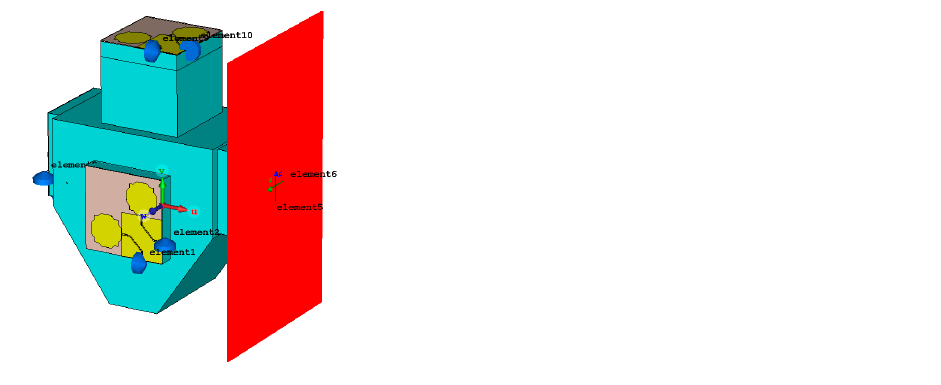
Figure 24. CST model for the example of electromagnetic plane wave incident from ( θ = π /2, φ = 0), with horizontal (Z) polarization.